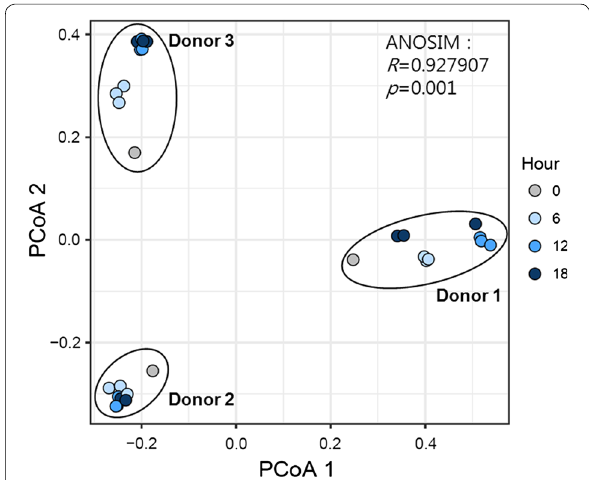
Fig. 3 PCoA based on Bray–Curtis distances of fecal samples incubated with pectin for various incubation